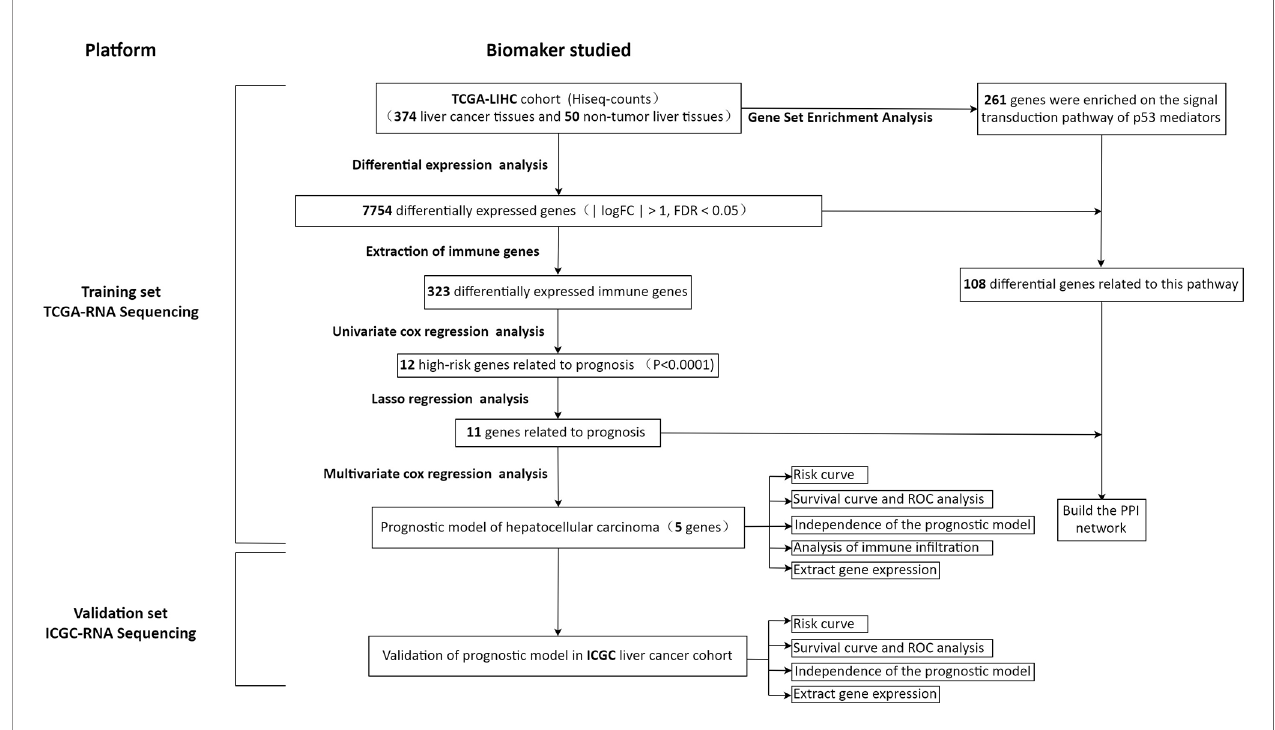
FIGURE 1 | Flow chart of this